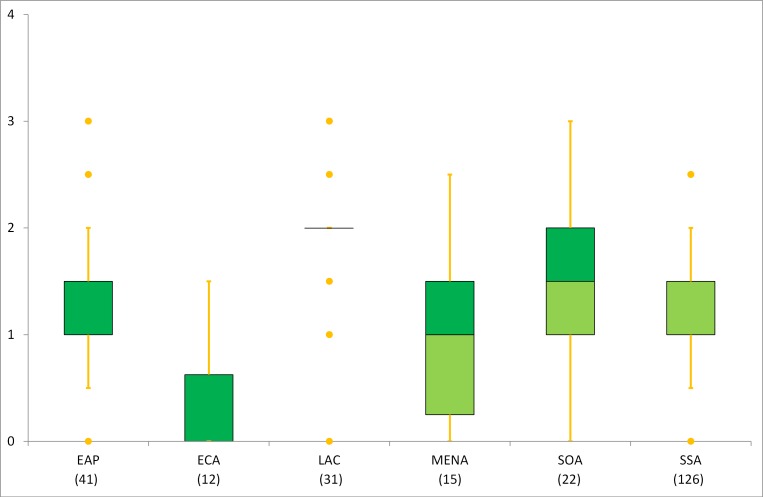
Box plots of S-scores by region.The bottom (light green) and top (dark green) of the box represent the 25th and 75th percentiles respectively.